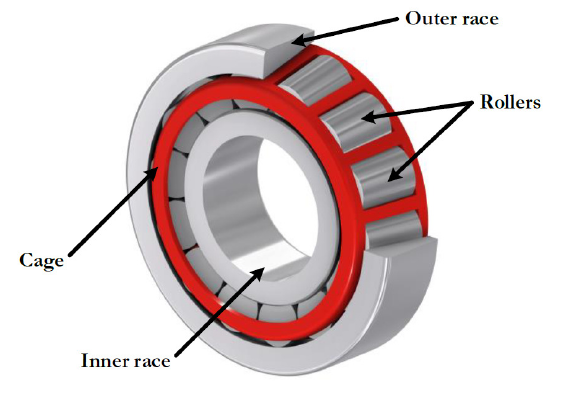
Figure 9. Parts of the tapered roller bearing in the reciprocating